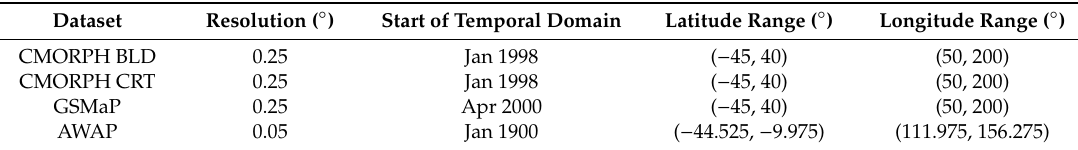
Table 1. Details about dataset